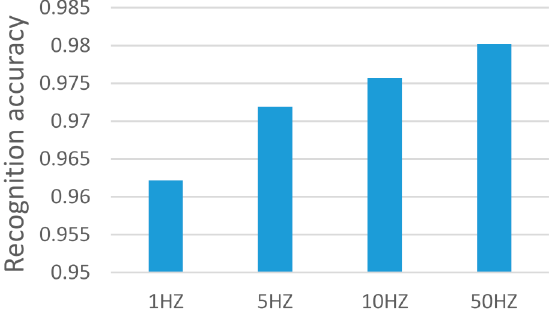
Figure 10. Recognition accuracy of activities at different sampling rates.